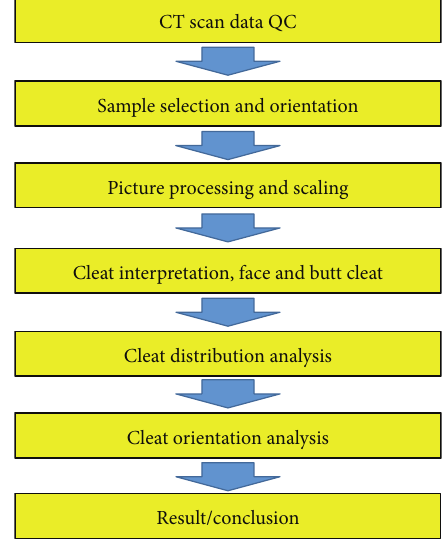
Figure 2: Workflow CT scan for 3D reconstruction.